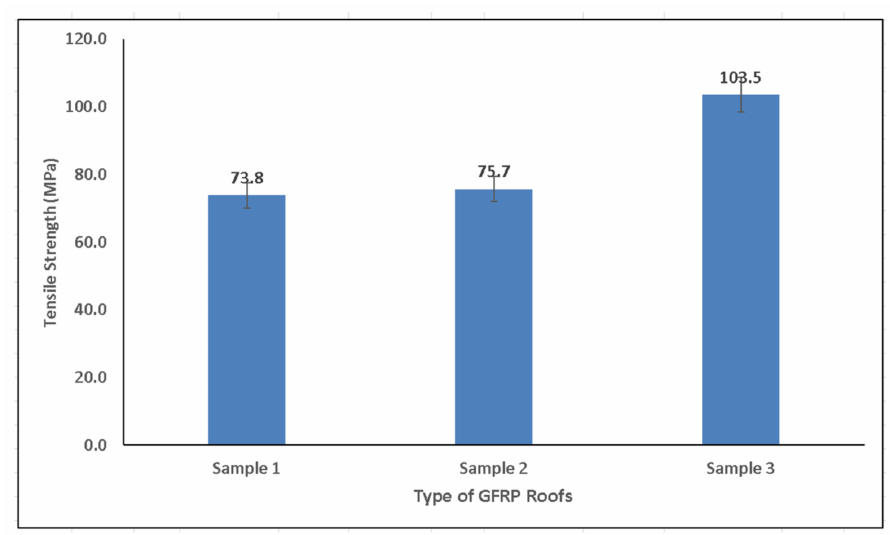
Figure 6. Tensile strength of GFRP composite roofs.